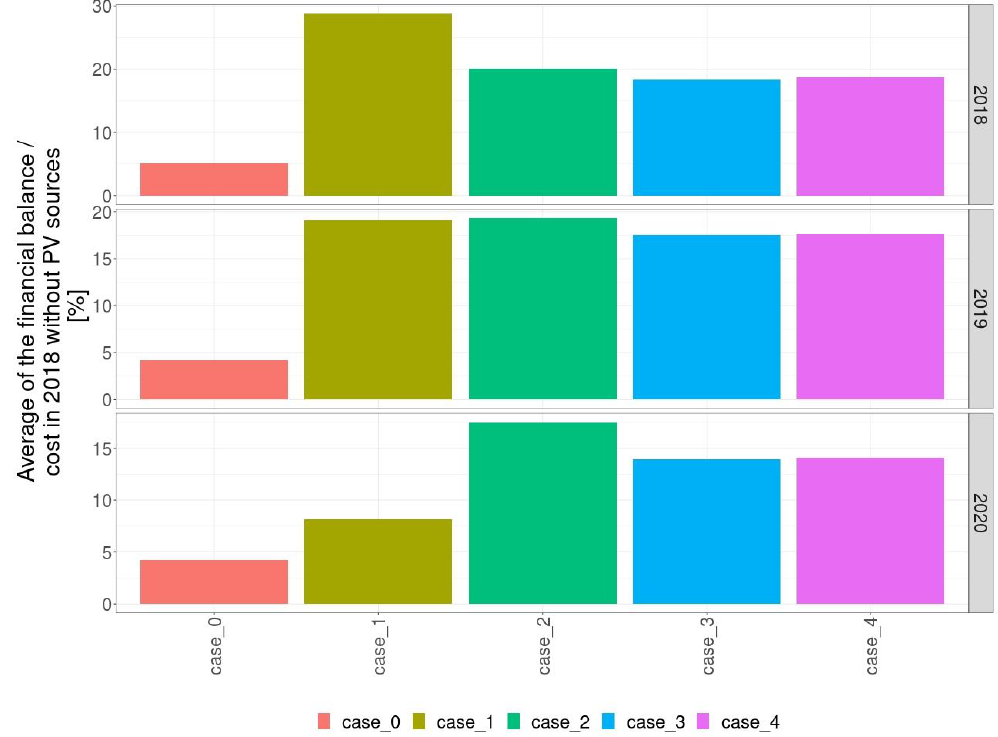
Figure 9. Share of the averaged balance of energy purchase costs for all prosumers for each year in the 2018 – 2020 period in relation to the energy purchase costs in 2018 prior to obtaining the status of prosumers. For each year in the 2018 – 2020 period, the most beneficial results of minimizing the energy purchase costs were recorded for the existing discount scenario-case_0. It should be stressed that the reduction in the electricity consumption arising from restrictions in the operation of various sectors of the economy, resulting in its resale on the market, had a positive impact on cost reduction through revenue from resold energy. This is particu- larly visible for the case_1 scenario, where the share of the cost was reduced from 29% in 2018 to 8% in 2020. It should be noted that in principle the case_2 scenario, assuming that energy is stored in the network and taken without discount coefficients, generates a higher cost than the models assuming the resale of surplus on the market: case_1, case_3 and case_4. The lack of cost competitiveness in the case_1 scenario is caused by the need to pay distribution fees for all electricity taken from the network. ● The results obtained make it possible to assess the effectiveness of the proposed models of support for prosumers by referring to particular areas of the economy, as shown in Figure 10, and individual prosumers representing individual sectors of the economy, as shown in Figure 11. In each case, for the years when the energy consumption was stable and corresponded to the level for which the PV source power was selected, the most beneficial prosumer support scenario is the existing discount model-case_0.